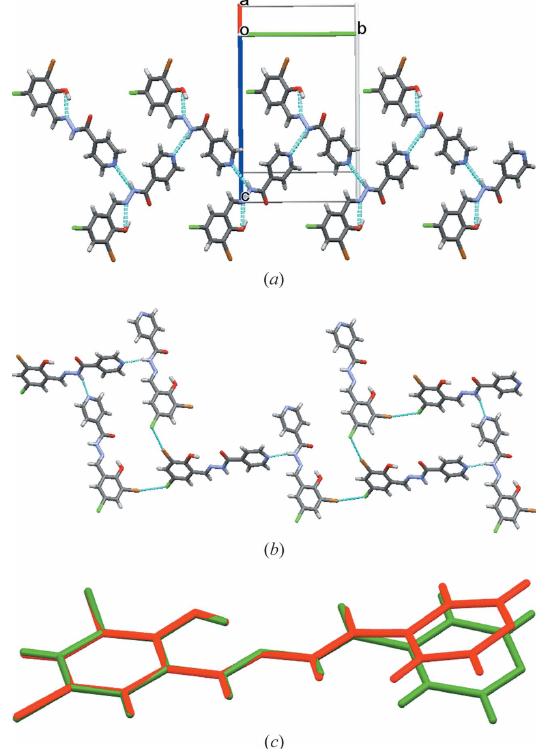
Figure 5 ( a ) The one-dimensional chain propagating through the N—H (cid:2)(cid:2)(cid:2) N (amino-pyridine) synthon (Form I, Compound-C). ( b ) Cl (cid:2)(cid:2)(cid:2) Br type II halogen-bonding interactions. ( c ) Overlay of Form I (green) and Form II (red)